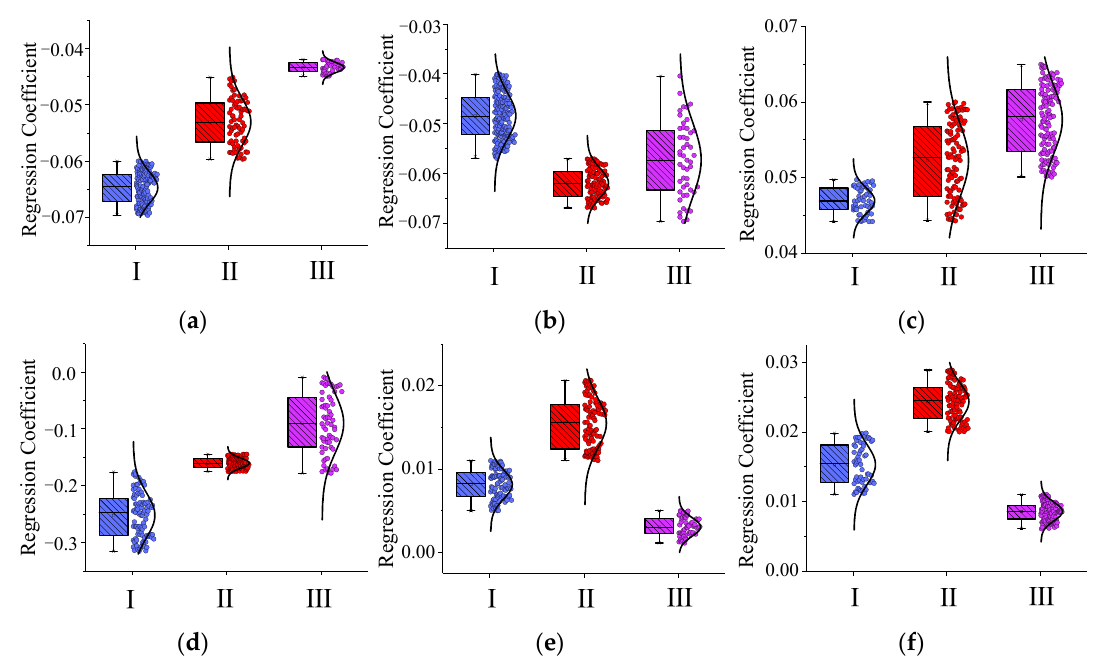
Figure 7. Second-order clustering results of the regression coefficients of the geographically weighted regression model at the 40 km analysis scale. ( a ) The width of the multifractal spectrum; ( b ) The difference of the multifractal spectrum; ( c ) Slope; ( d ) Average elevation; ( e ) Elevation maximum; ( f ) Elevation minimum.